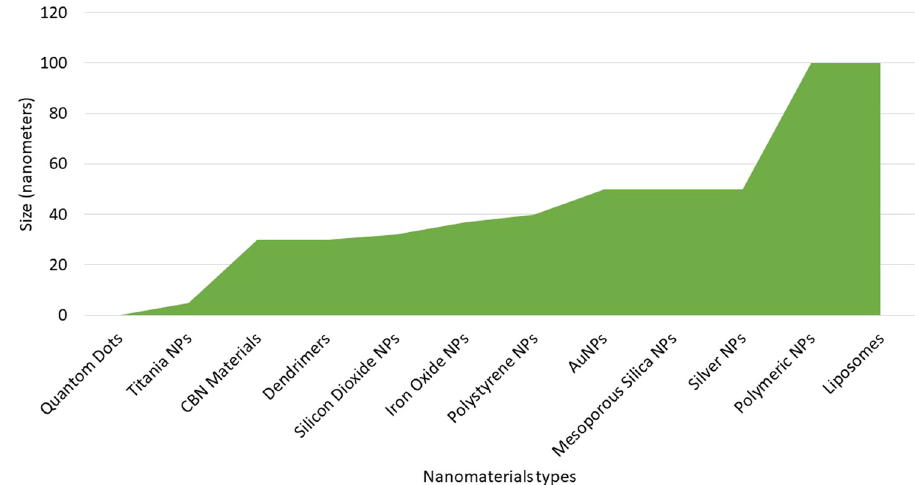
Figure 15: Comparative nano - scale ( optimum ) sizes of various nano - carriers for cellular